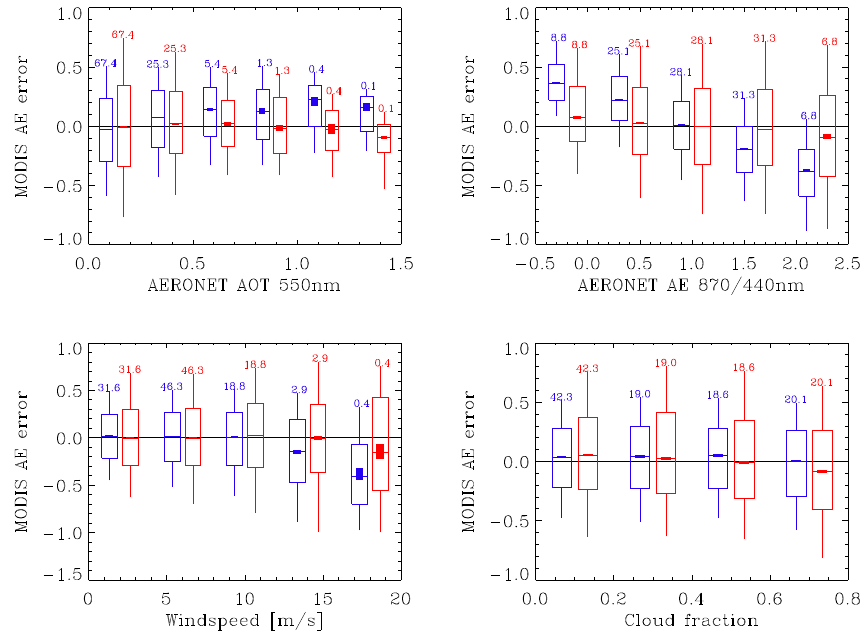
Fig. 12. MODIS Aqua error statistics as a function of AERONET AOT, AERONET AE, NCEP-DOE-II wind speed and MODIS cloud frac- tion for the original (blue) and the corrected AE (red). The box–whisker plots are offset from these bin centres to show the two distributions side by side. Numbers above the box and whisker show the percentage of the total sample used in that bin.